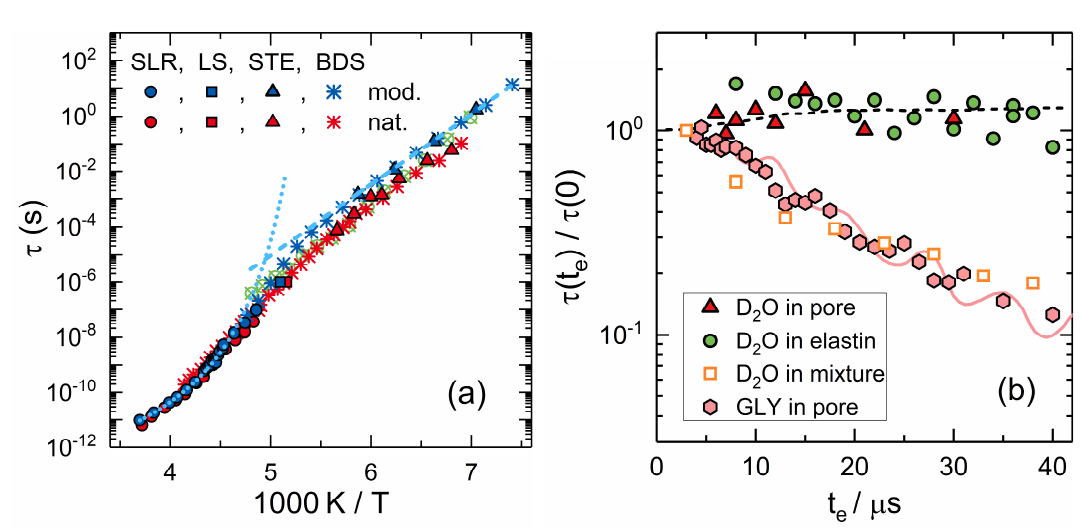
Figure 5. ( a ) Temperature-dependent correlation times of H 2 O and D 2 O reorientation in native MCM-41 (diameter 2.0 nm, red symbols) [214] and in APTES modified MCM-41 (diameter 2.2 nm, blue symbols) [181]. Results from 2 H spin-lattice relaxation, line-shape analysis, and stimulated-echo experiments on D 2 O dynamics and from BDS on H 2 O dynamics in native MCM-41 [227] and D 2 O dynamics in modified MCM-41 [181] are shown. For comparison, data from combined NMR and BDS studies on water reorientation in an elastin matrix are included (green crossed circles) [222]. The dotted line is an interpolation of the high-temperature data with a Vogel-Fulcher-Tammann relation. The dashed line is an Arrhenius fit of the low-temperature results, yielding an activation energy of 0.5 eV. ( b ) Evolution-time dependent normalized correlation times τ (t e ) / τ (t e → 0) of D 2 O reorientation in an APTES modified MCM-41 (pore) [181], in an elastin matrix [220], and in a 2:1 molar D 2 O / DMSO mixture [228], and of glycerol (GLY) reorientation in MCM-41 (diameter 2.2 nm). The lines are expectations obtained from computer simulations [229]: (dashed) distorted tetrahedral jumps [220] and (solid) isotropic reorientation comprised of rotational jumps about angles of 2 ◦ (98%) and 30 ◦ (2%) [230].